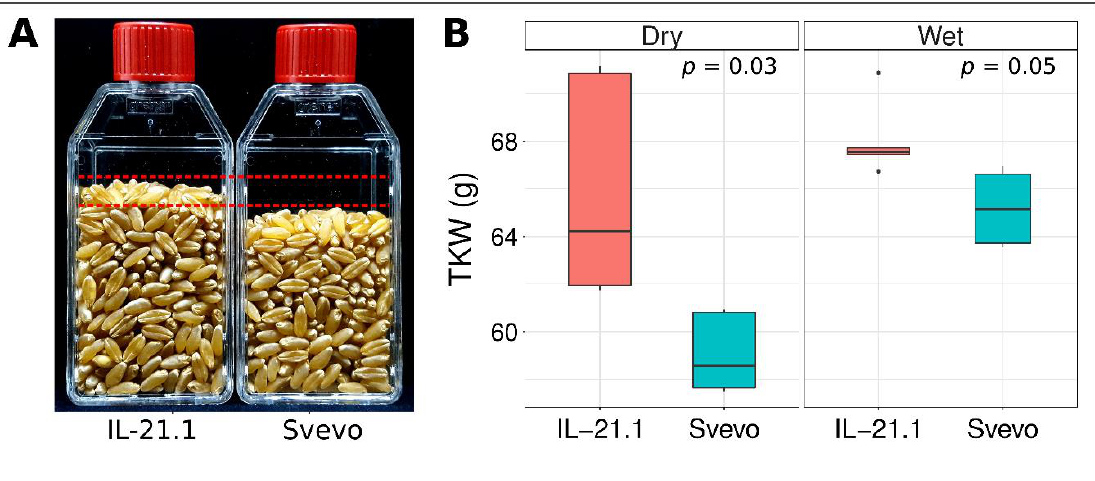
Figure 2. Comparison of TKW between durum parent Sv and IL-21.1 carrying the mQTL-GW-6A region. ( A ) Samples of 500 grains from the 2017R environment. ( B ) Boxplot showing quantile statistics for TKW from the 2017R two environments (e.g., dry and wet).